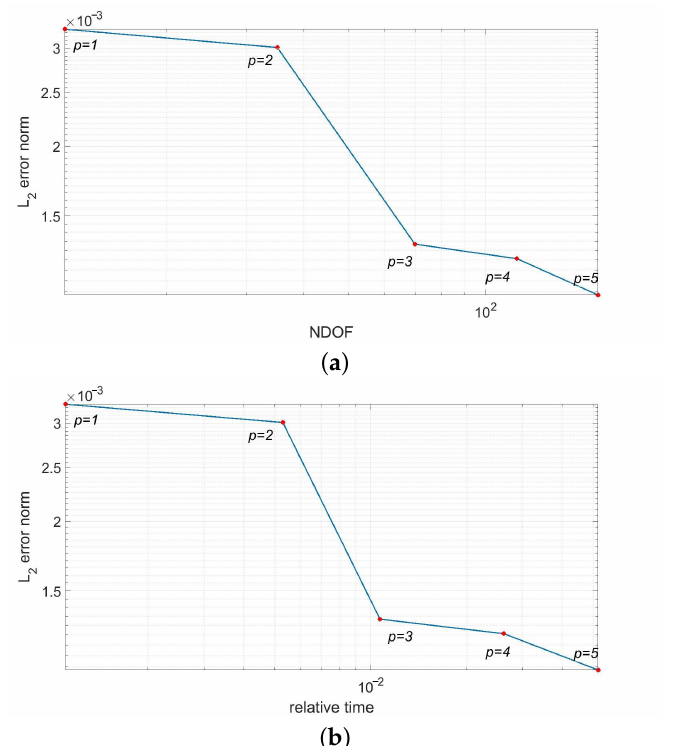
Figure 7. Convergence test for the increasing approximation orders at the macroscale (logarithmic scale) w.r.t. ( a ) number of degrees of freedom and ( b ) relative time (the ratio of the computational time used for the upscaled and reference